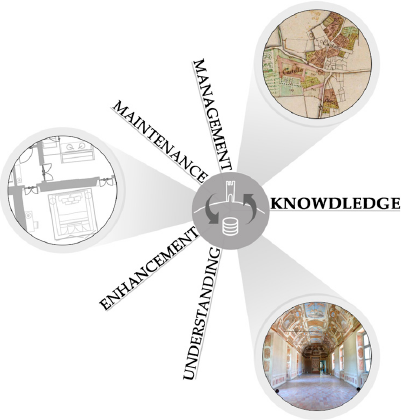
Figure 2. Datasets taken into account in data collection step.